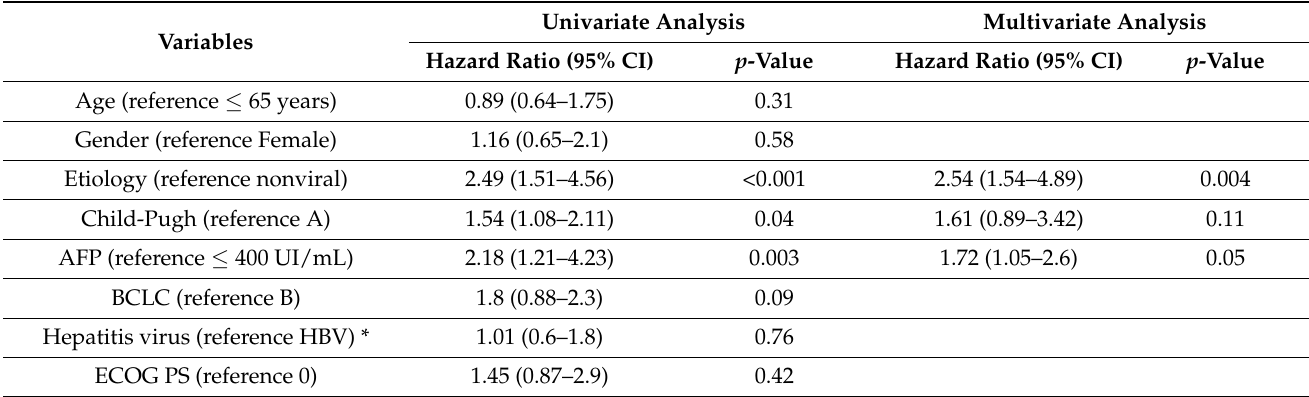
Table 4. Cox univariate/multivariate regression for progression-free